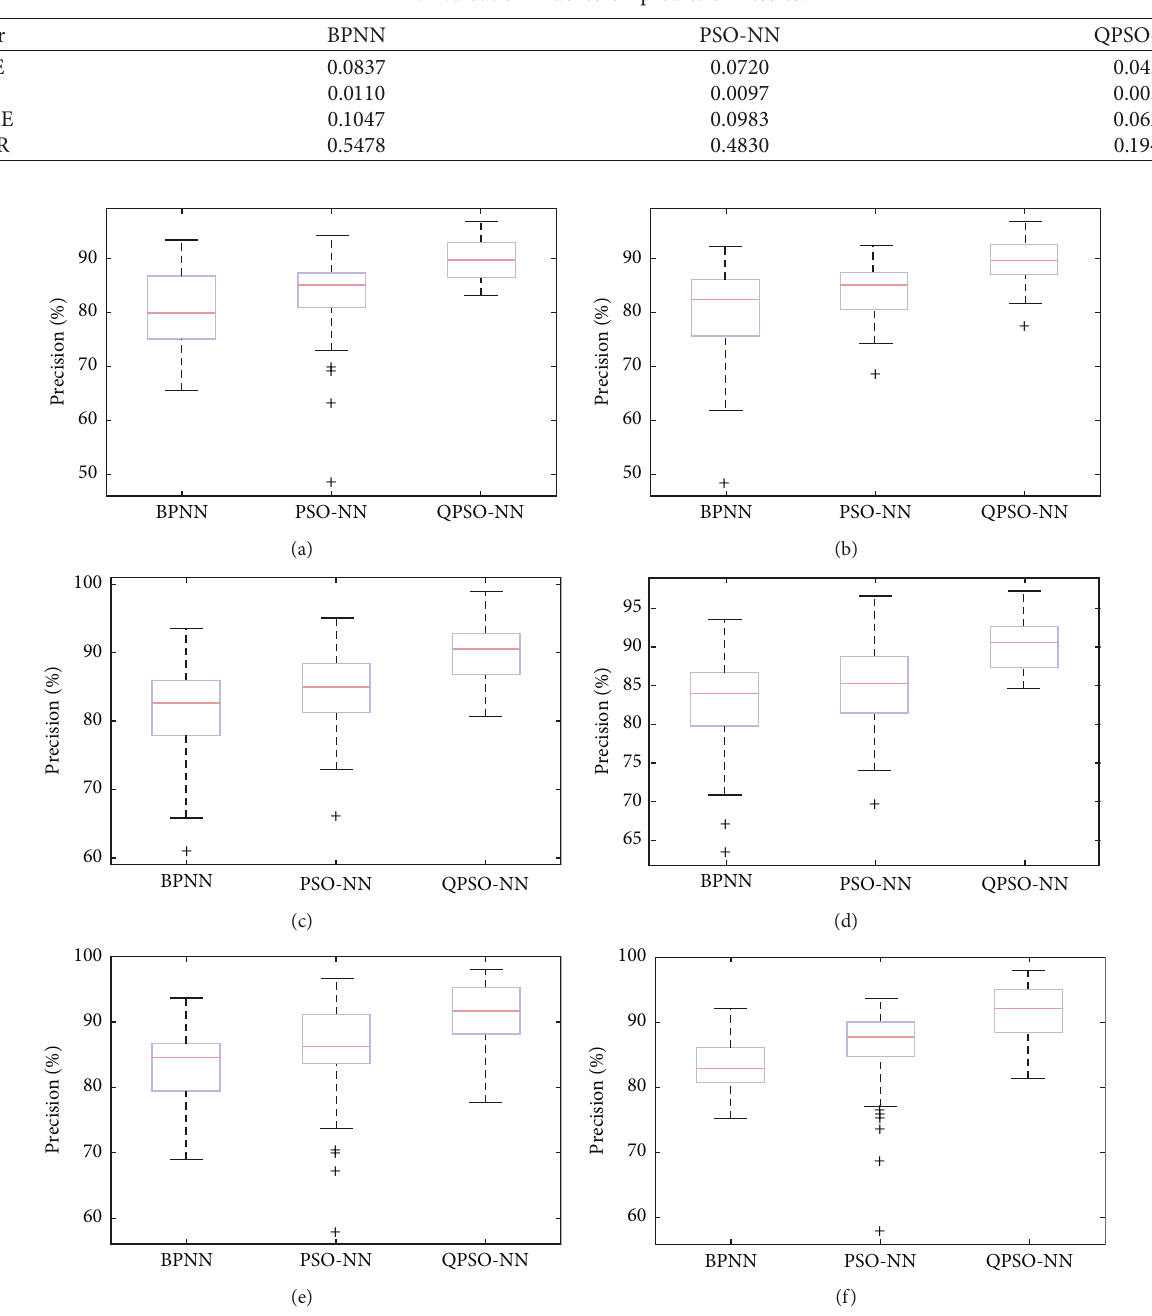
Figure 9: Precision distributions of three algorithms in different training set ratios: (a) 40%; (b) 50%; (c) 60%; (d) 70%; (e) 80%; (f) 90%.